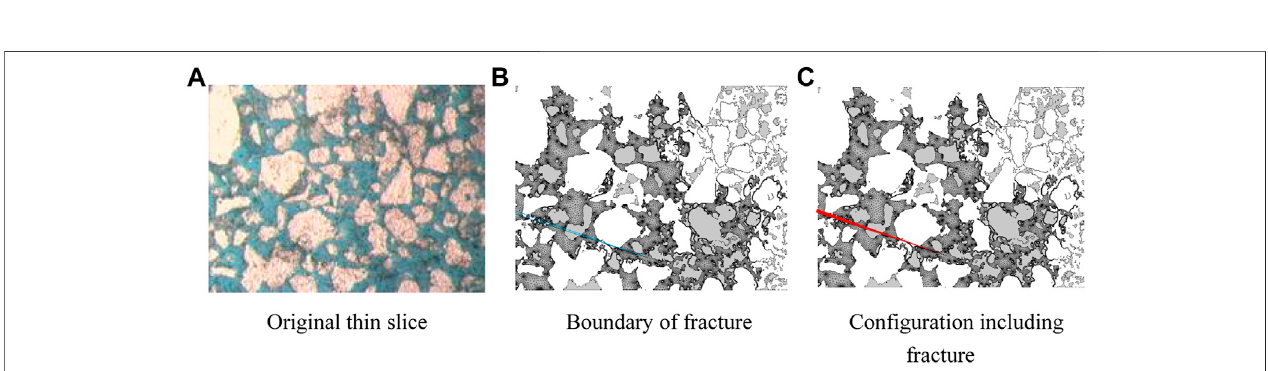
FIGURE 7 | Schematic diagram of the construction process. (A) Original thin slice, (B) boundary of fracture, and (C) con fi guration including.